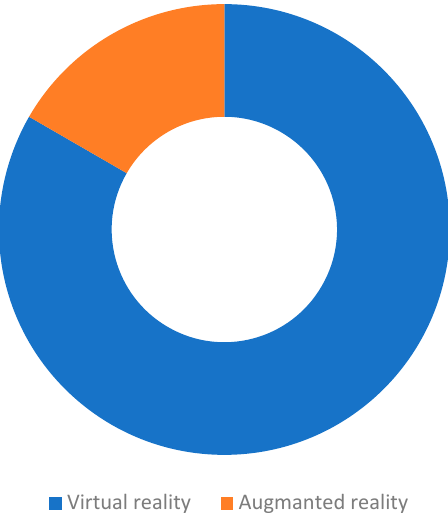
Figure 4. Types of specific phobias.